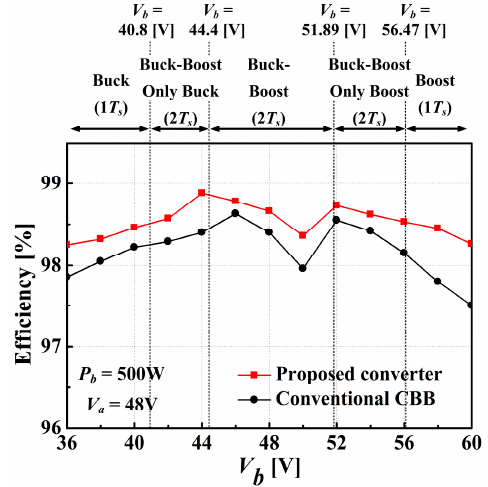
Figure 19. η e vs. V b at V a = 48 V and P b = 500 W.